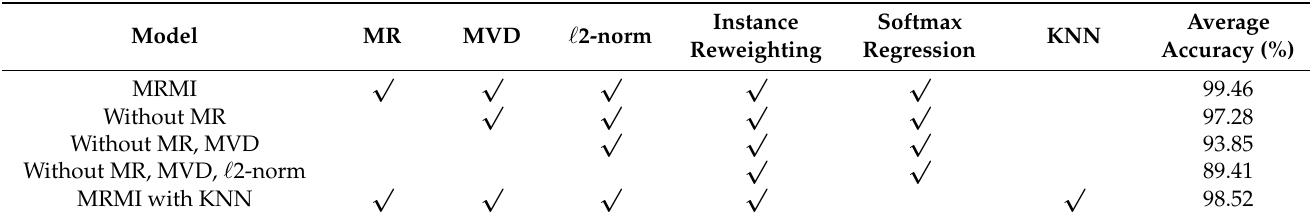
Table 4. An ablation study for MRMI: Performances are evaluated on rolling bearing dataset.